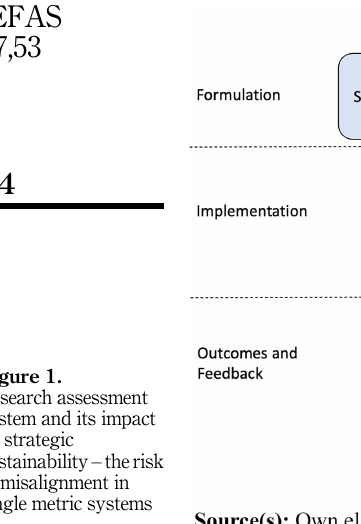
Figure 1. Research assessment system and its impact on